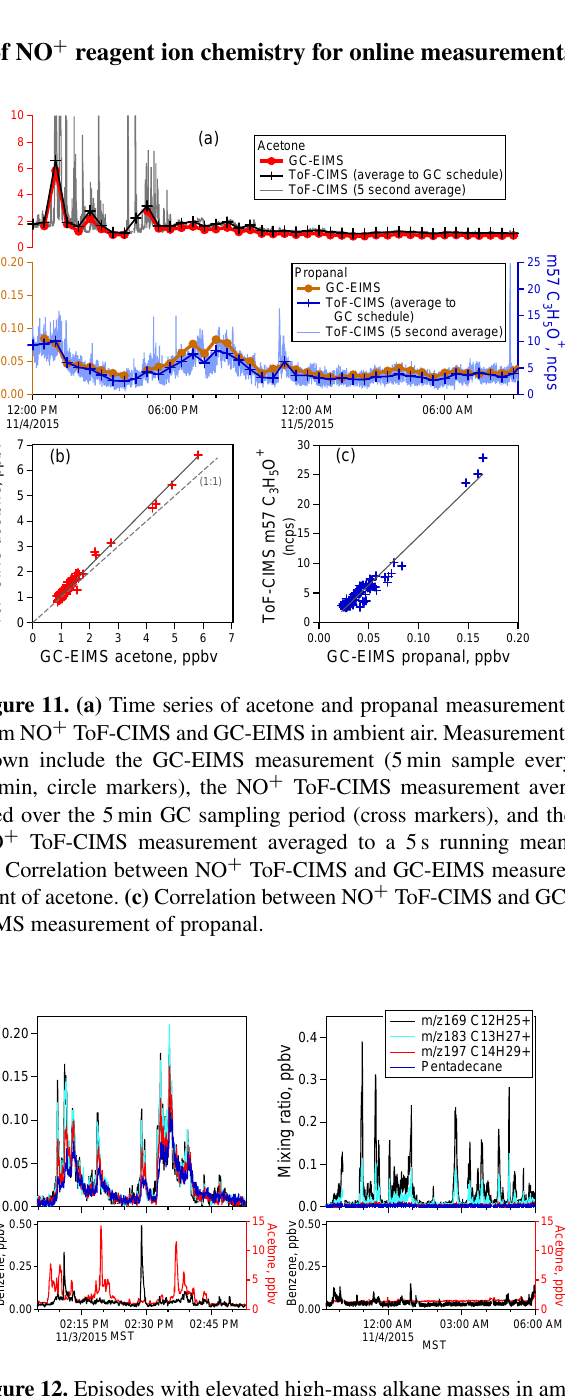
Figure 12. Episodes with elevated high-mass alkane masses in am- bient air. Mixing ratios for m/z 169 C 12 H + (dodecane), m/z 183 25 C 13 H + (tridecane), and m/z 197 C 14 H + (tetradecane) are shown 27 29 in approximate ppbv, assuming the same instrument calibration fac- tor as pentadecane. Additional VOC species (benzene, acetone) are shown in the bottom panels for